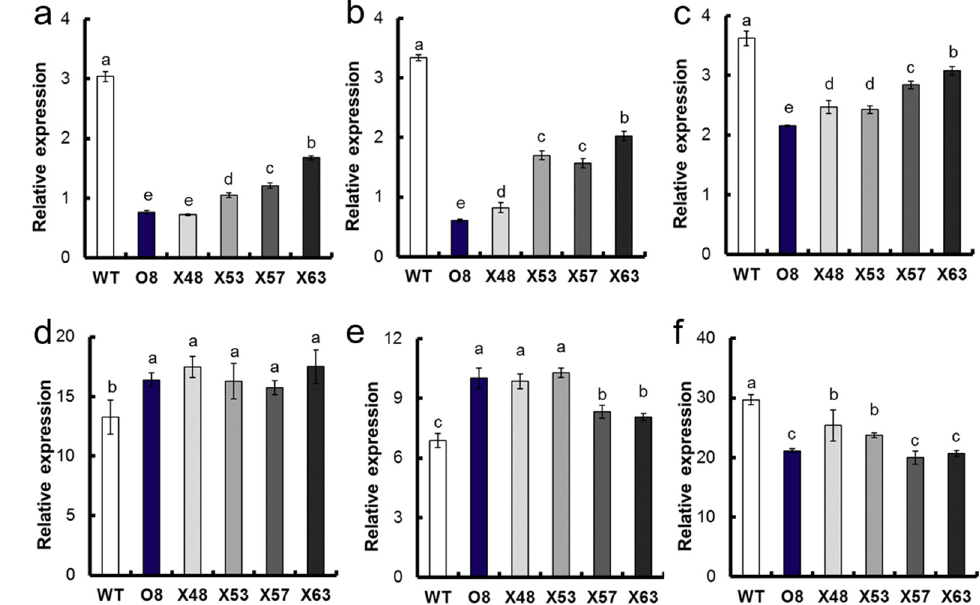
Figure 3. Characteristics of WT, O8, and EMS mutants in M6 generation. ( a ) Phenotype of O8 and EMS mutants in WT at maturity stage. ( b ) Real-time quantitative RT-PCR analysis of endogenous OsNRT2.3b expression in various overexpressing lines and WT plants. RNA was extracted from leaf blade I. Error bars: SE ( n = 3 plants). ( c ) Days to heading of WT and overexpressing lines. Days to flowering was scored when the first panicle was bolted. Error bars: SE ( n = 10 plants). ( d ) Growth duration of WT, O8, and EMS mutants. The 90% seeds of the main panicle are fully mature. Error bars: SE ( n = 10 plants). Significant differences between the WT and OsNRT2.3b overexpressing lines are indicated by different letters ( p < 0.05, one-way ANOVA).